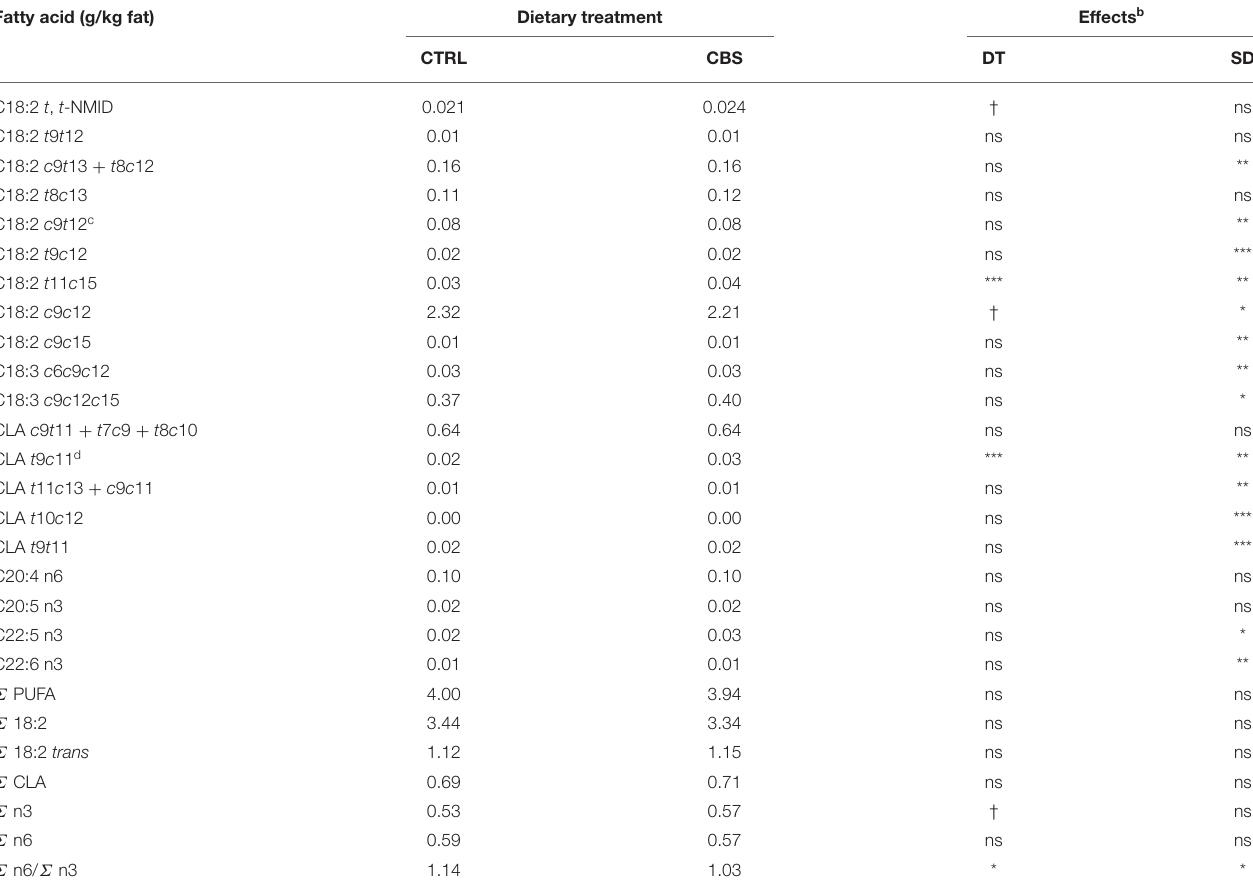
TABLE 6 | Polyunsaturated fatty acids (g/kg fat) in milk of goats fed the control (CTRL) and cocoa bean shell (CBS) diets a . Fatty acid (g/kg fat) Dietary treatment Effects b